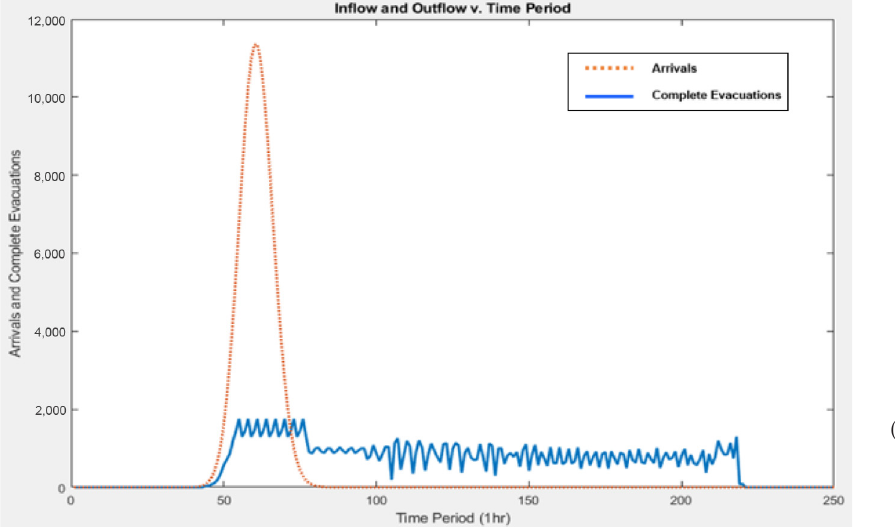
Figure 6. (color online) In fl